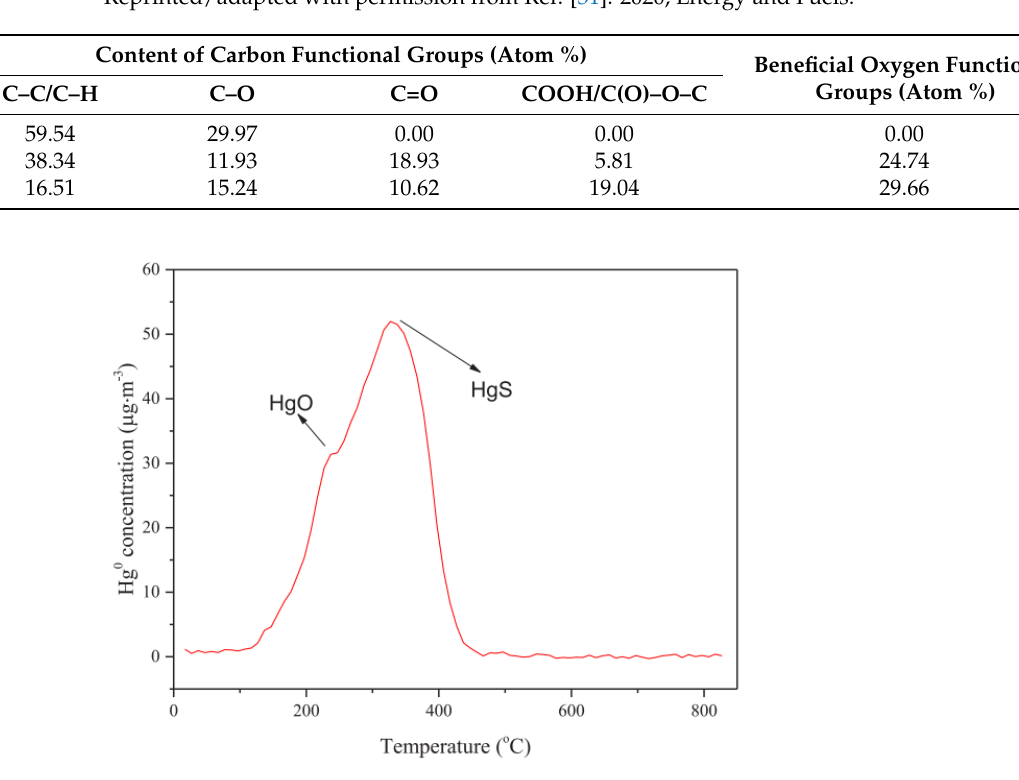
Figure 6. TPD results of CSAC after mercury adsorption [31]. Reprinted/adapted with permission from Ref. [31]. 2020, Energy and Fuels.